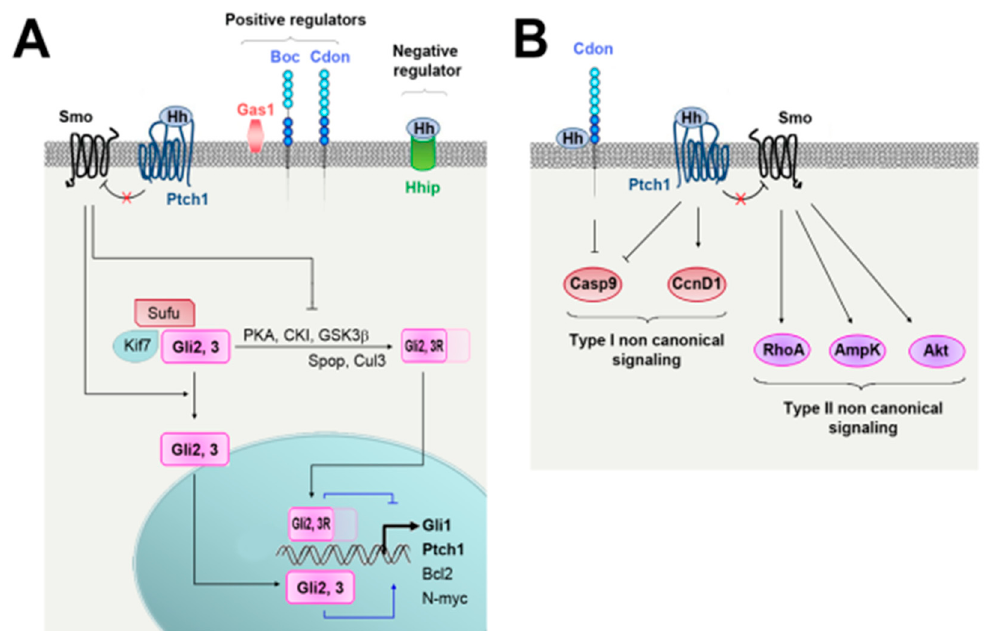
Figure 2. ( A ) Hh canonical signaling. In the absence of Hh ligands, Smo is inhibited by Ptch1 and Gli transcription factors are associated with SUFU negative regulator of hedgehog signaling (Sufu) and kinesin family member 7 (Kif7). This last complex promotes Gli3 and Gli2 phosphorylation by cAMP dependent protein kinase (PKA), casein kinase 1 (CK1), and glycogen synthase kinase 3 beta (GSK3. Once phosphorylated, Gli2 and Gli3 are processed by speckle type BTB / POZ protein (Spop) / cullin 3 (Cul3) ubiquitin ligase complex to generate Gli2R and Gli3R (repressor forms) respectively. Hh ligands binding to Ptch1 leads to Smo activation, which prevents Gli2 and Gli3 cleavage. Full-length Gli2 and Gli3 may then translocate to the nucleus and activates transcription. ( B ) Hh noncanonical signaling. Hh binding to Ptch1 or Cdon may, independently on Smo, promote cell survival or proliferation by modulating Caspase 9 (Casp9) or Cyclin D1 (CcnD1) activity, respectively. This is what is called type I noncanonical signaling. Alternatively, Hh ligands may activate PI3K / Akt, RhoA / ROCK or AMPK, via Smo, but independently on Gli transcription factors. This is what is called type II noncanonical signaling.